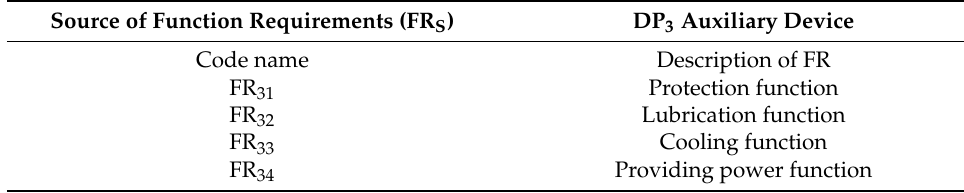
Figure 13. Schematic generation process diagram of FR 3 s. Table 9. List of FR 31 , FR 32 , FR 33 , FR 34. Table 9. List of FR 31 , FR 32 , FR 33 , FR 34 .